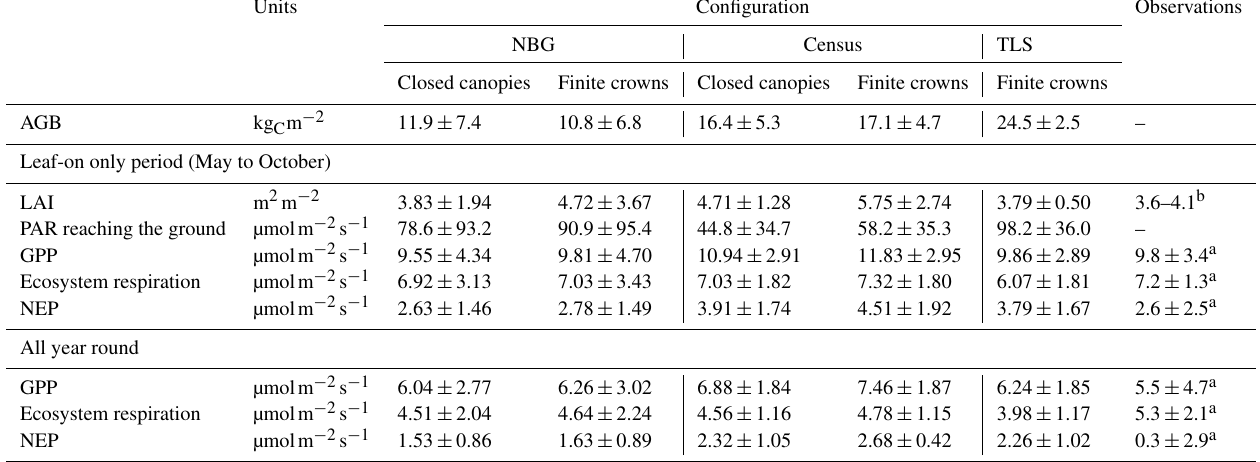
Table 6. Summary of most important states and fluxes in all three model configurations and how they compare with observational datasets, including flux tower data on ecosystem respiration and net ecosystem productivity. Those numbers take into account the full 5 years of simulation for the prescribed model configurations (Census and TLS), the last 5 years of simulation for near-bare-ground conditions (NBG), and the 2 years of eddy covariance observational data. For the observations of LAI in the leaf-on season, we provide a range of variation. LAI: leaf area index, AGB: aboveground biomass, GPP: gross primary production, NEP: net ecosystem productivity, PAR: photosynthetically active